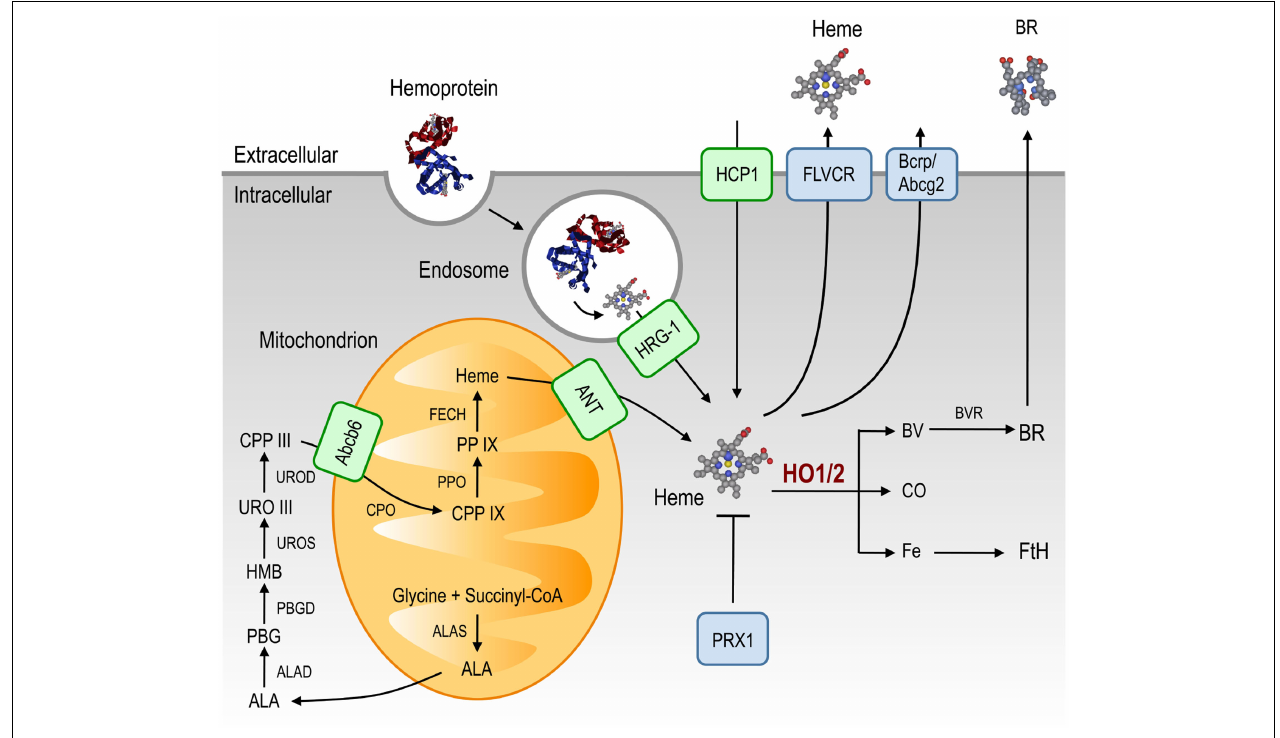
the expression of FtH that scavenges excess cellular Fe. Abbreviations: Abcb6, ATP-binding cassette b6; ALA, δ -aminolevulinic acid; ALAD, ALA dehydratase; ALAS, ALA synthase; ANT, adenine-nucleotide translocator; Bcrp/Abcg2, breast cancer resistance protein/ATP-binding cassette g2; BR: bilirubin; BV, biliverdin; BVR, BV reductase; CO, carbon monoxide; CPP, coproporphyrinogen; CPO, CPP oxidase; Fe, iron; FECH, ferrochelatase; FLVCR, feline leukemic virus receptor; Fth, ferritin; HCP1, heme carrier protein-1; HMB, hydroxymethylbilane; HO, heme oxygenase; HRG-1, heme responsive gene-1; PBG, porphobilinogen; PBGD, PBG deaminase; PP IX, protoporphyrin IX; PPO, protoporphyrinogen oxidase; PRX1, peroxiredoxin-1; URO, uroporphyrinogen; UROD, URO decarboxylase; UROS, URO III